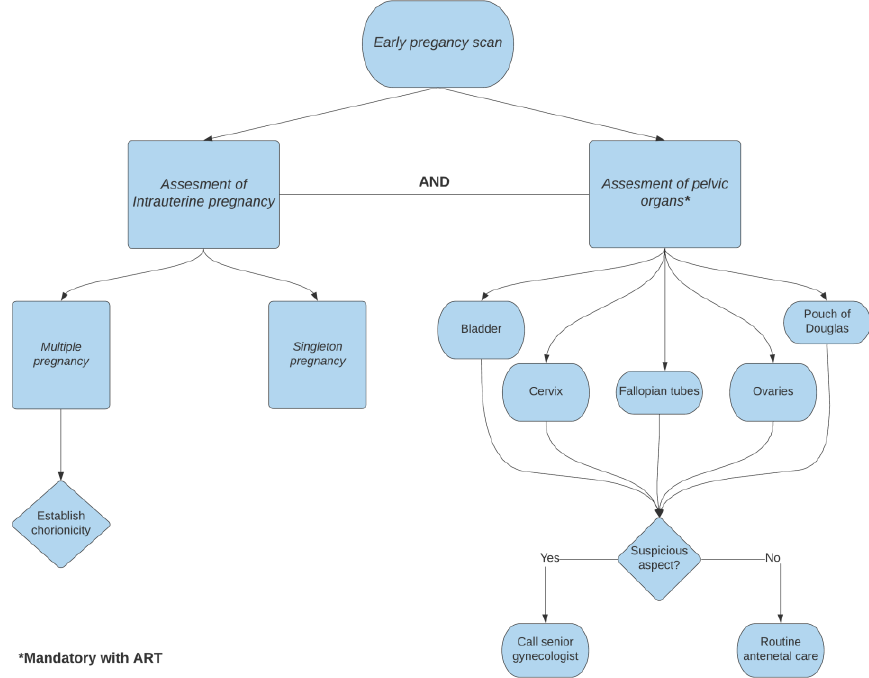
Figure 3. Flowchart on decision making after confirming an intrauterine pregnancy and assessment of pelvic organs.